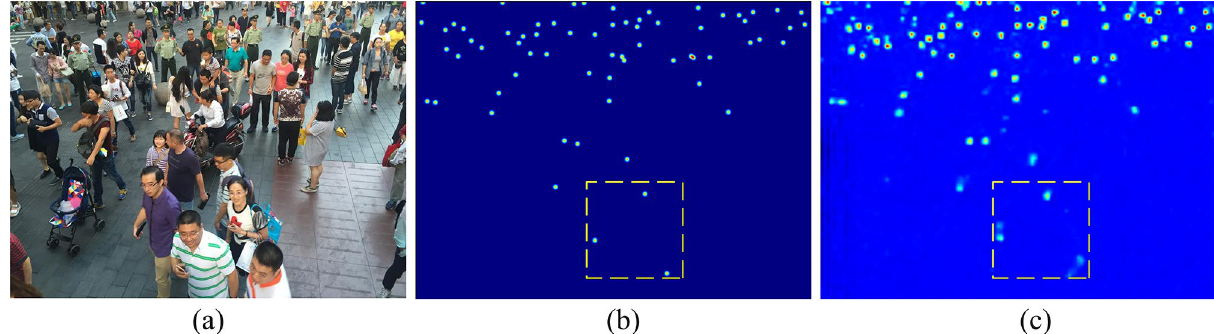
Figure 1. Visualization of density maps predicted from models trained with DConv. ( a ) is one of the input images in the ShanghaiTech B dataset, ( b ) is the ground truth, and the estimated density map is shown in ( c ) which shows less regular Gaussian